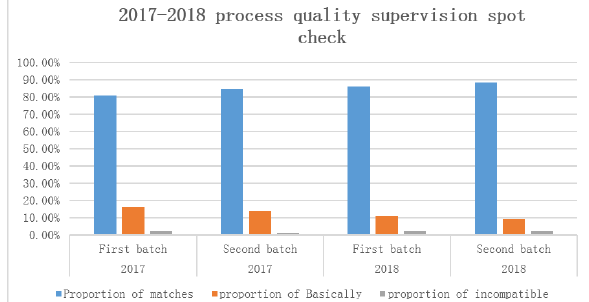
Figure 2. Compliance data of inspection items in 2017 and